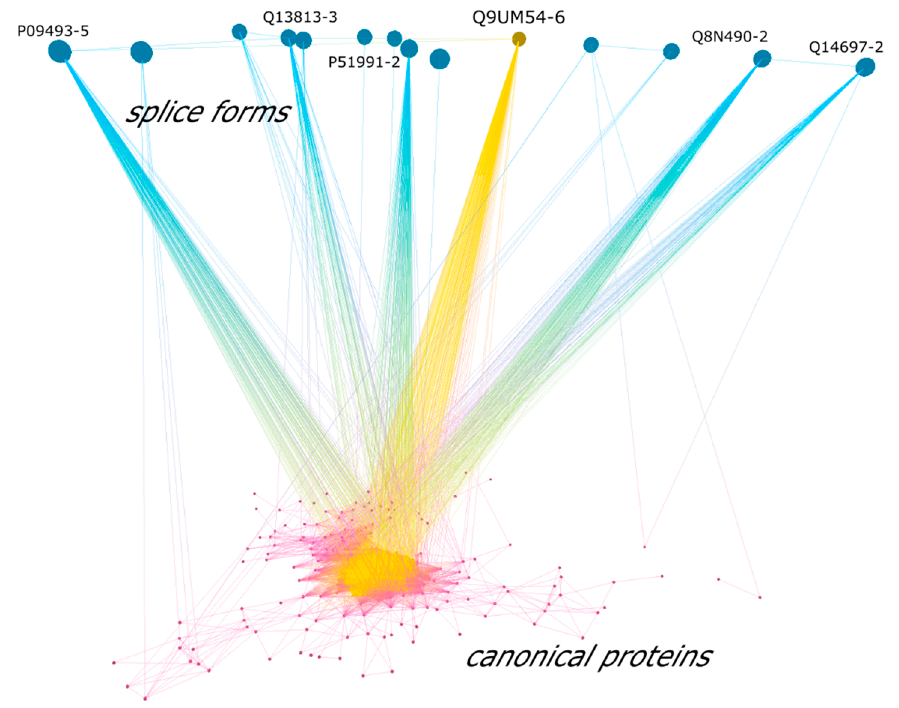
Figure 5. The largest connected component of the obtained PPI network showing canonical proteins (lower level) and their corresponding splice forms (upper level). Hub proteins with more than 150 interacting partners are marked with yellow, including splice form Q9UM54-6 for which we report 10% differences with its canonical form Q9UM54 in terms of PPIs.